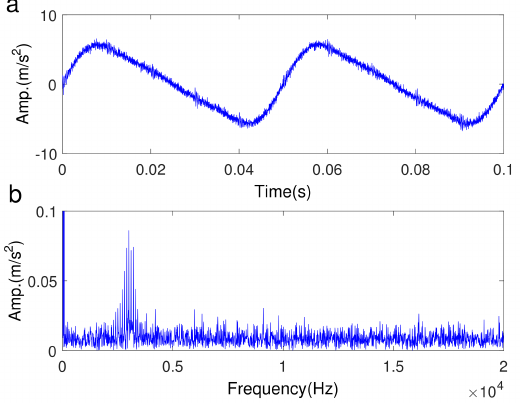
Figure 5. Simulated vibration signal ( a ) the time domain waveform ( b ) the FFT